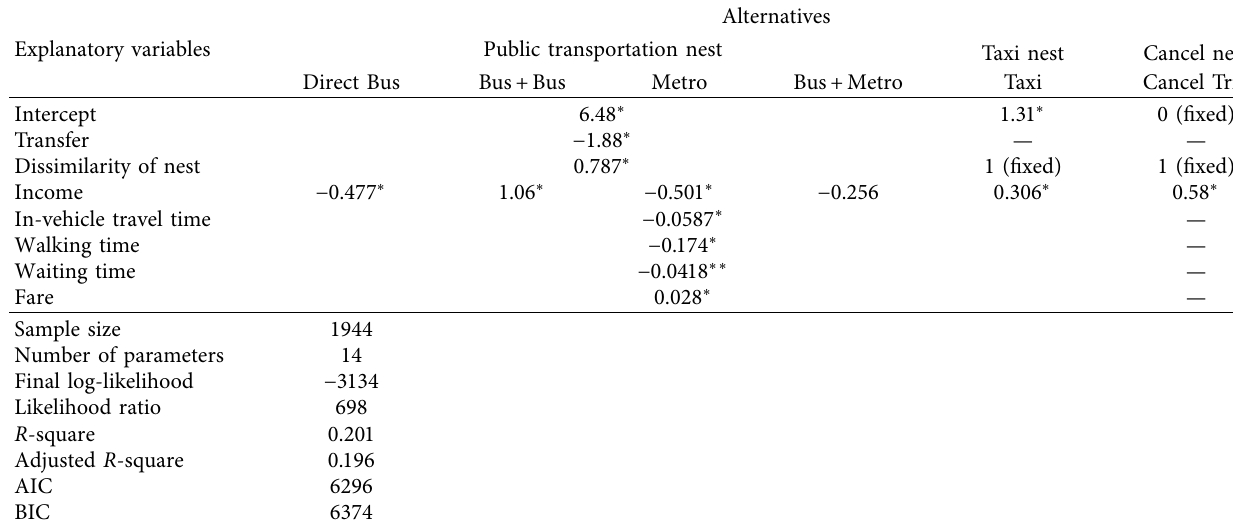
Table 4: Estimation